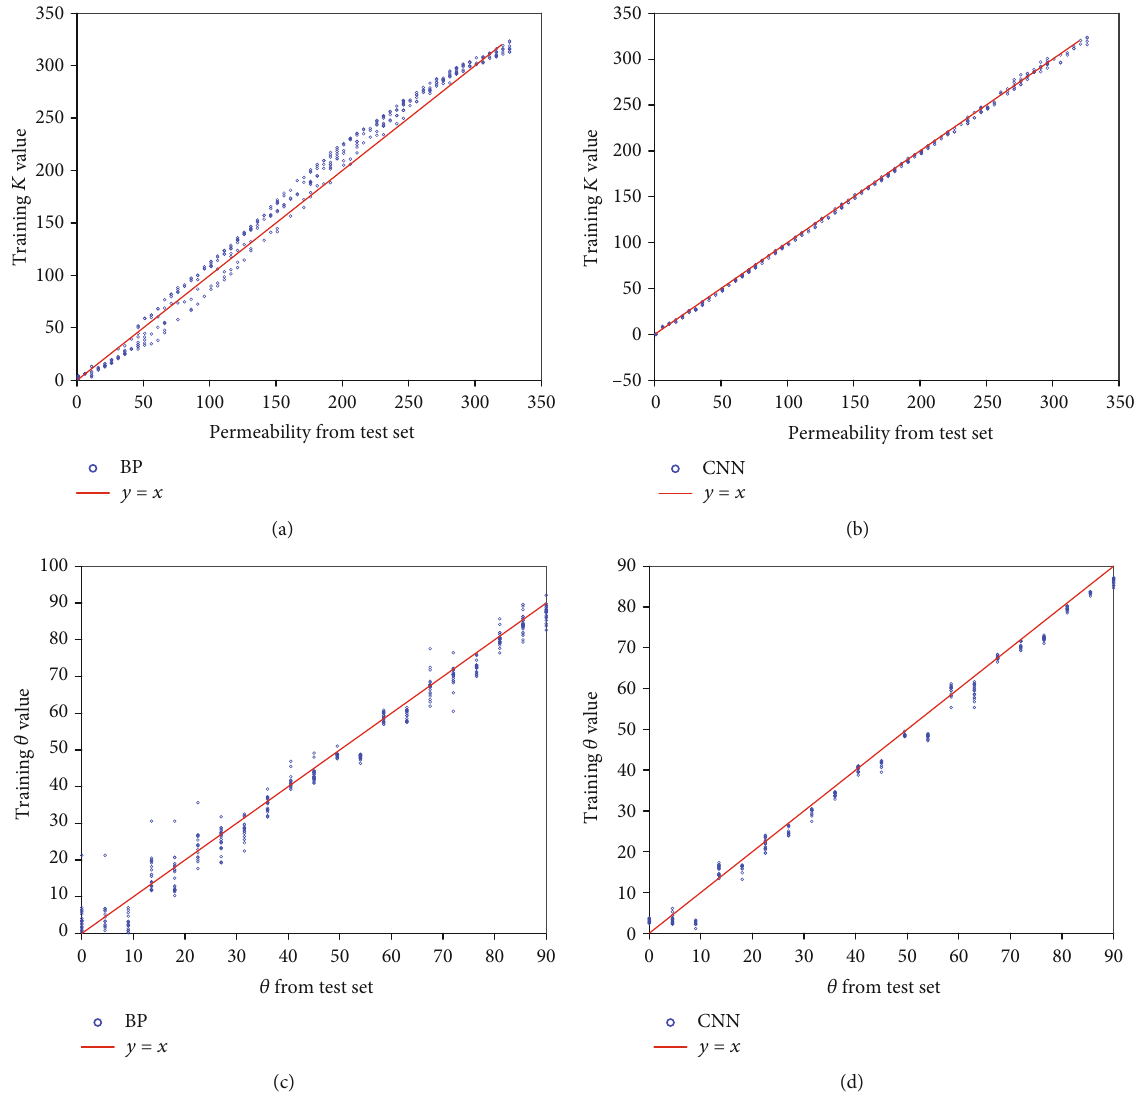
Figure 8: Comparison between test set and results predicted by di ff erent neural networks: (a) cross graph of K values predicted by BP neural network; (b) cross graph of K values predicted by CNN; (c) cross graph of θ values predicted by BP neural network; (d) cross graph of θ values predicted by